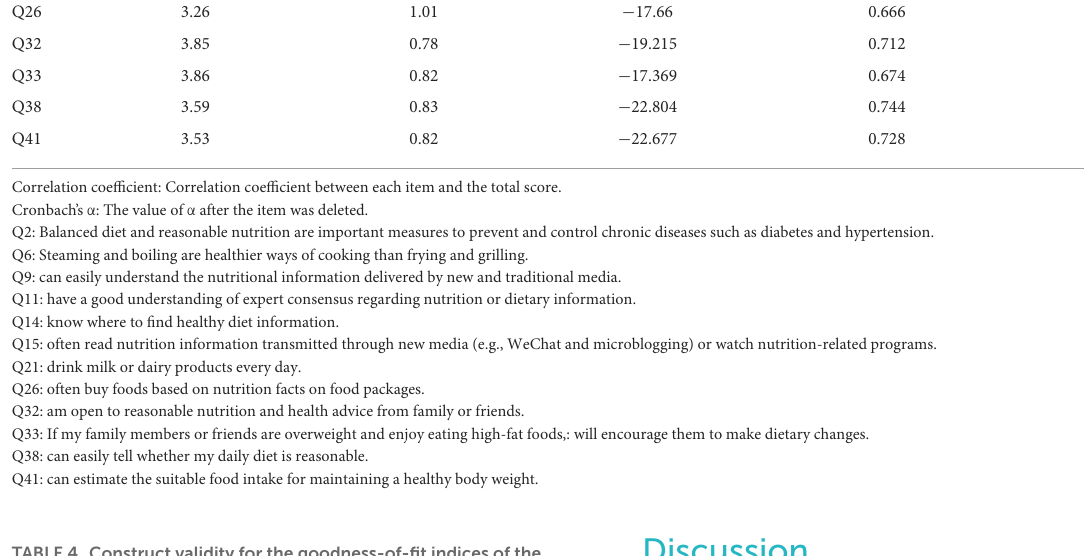
TABLE 4 Construct validity for the goodness-of-fit indices of the